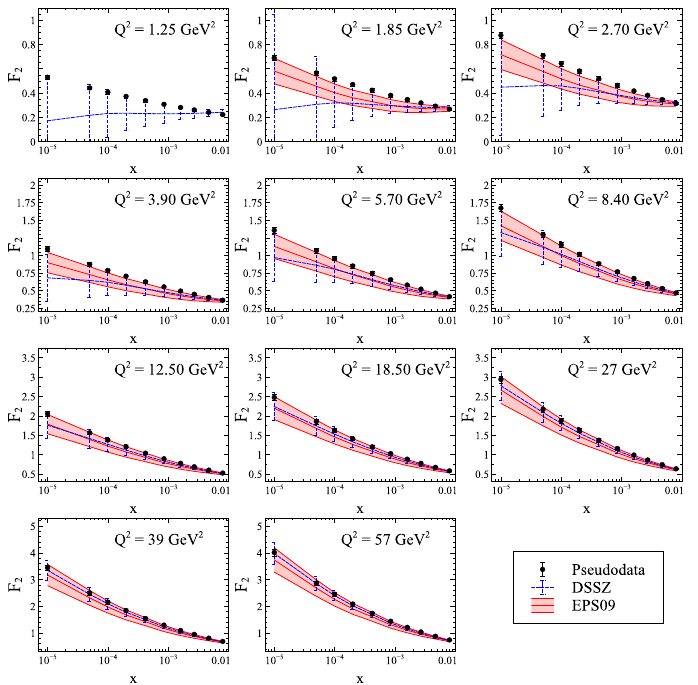
Figure 27. Comparison of the structure function F 2 obtained from the rcBK solutions to those from extrapolated nuclear PDFs. Figure from